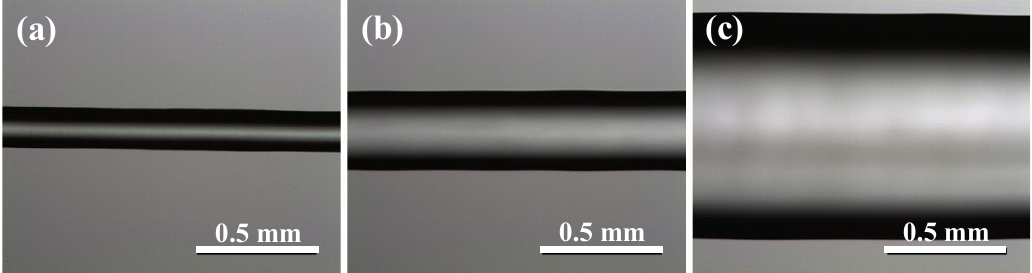
Figure 2. The printed results from the self-fabricated 3D bioprinting system using the combinations of 3BE-2 with ( a ) Φ 0.13 mm, ( b ) Φ 0.33 mm, and ( c ) Φ 0.9 mm needle head.